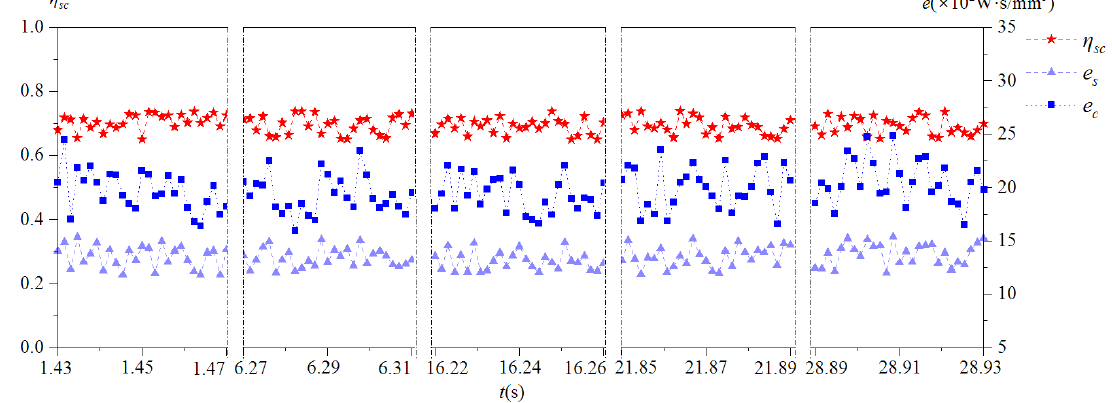
Figure 22. Variation in instantaneous cutting energy efficiency of milling cutter (scheme 2).